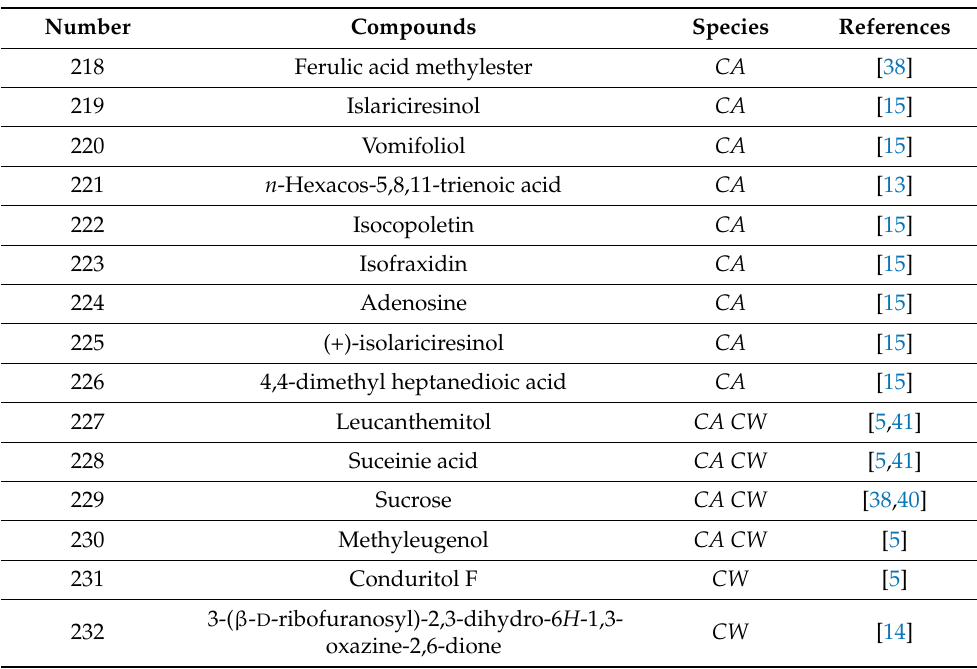
Table 5. Other compounds isolated from CA , CB , and CW